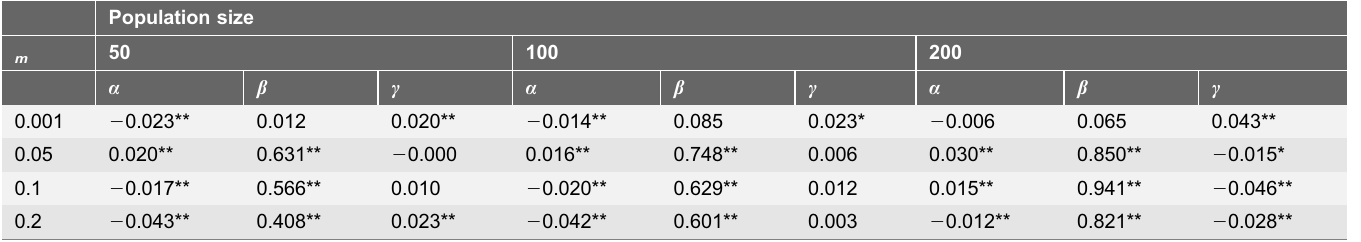
Table 1. Coefficients in the linear regression models PH ~ c z ad z b d z c ( d : d ) . Population size